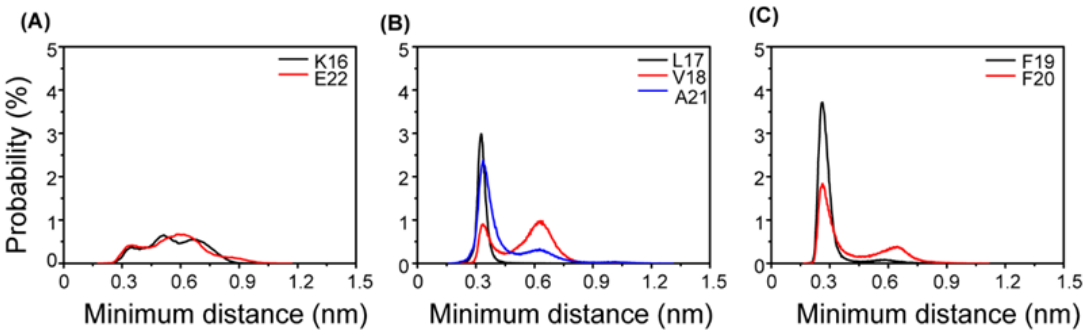
Figure 4. Probability distribution of the minimum distance between the side chain of each residue.and AuNPs’ surface in the Aβ tetramer/octamer + AuNPs system. The distance between AuNPs’ surface and ( A ) K16, E22, ( B ) L17, V18, A21, ( C )F19, F20.